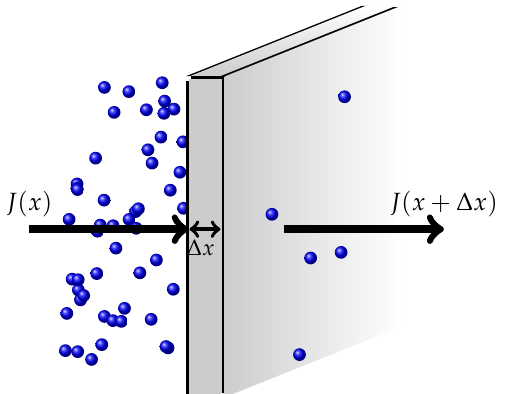
Figure 1. Particles randomly move through the porous medium according to a diffusion process; the arrows (vectors) represent also the flux of water